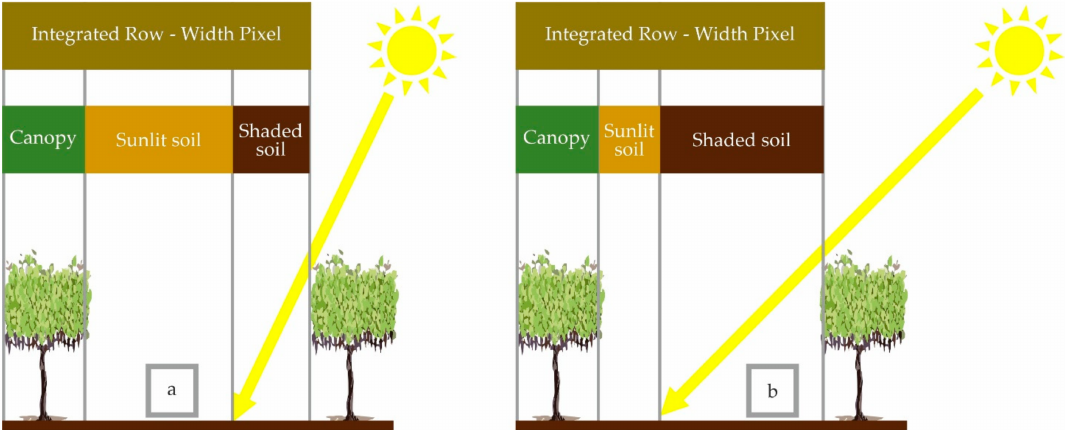
Figure 1. Schematic illustration of the contribution of different reflectance fractions in a vertical-shoot-positioned (VSP) to the integrated value of a row-width pixel for a given solar elevation. Diagram ( a ) shows the situation with high solar elevation; diagram ( b ) illustrates how at lower solar elevation the reflectance fractions, and hence their integrated value,